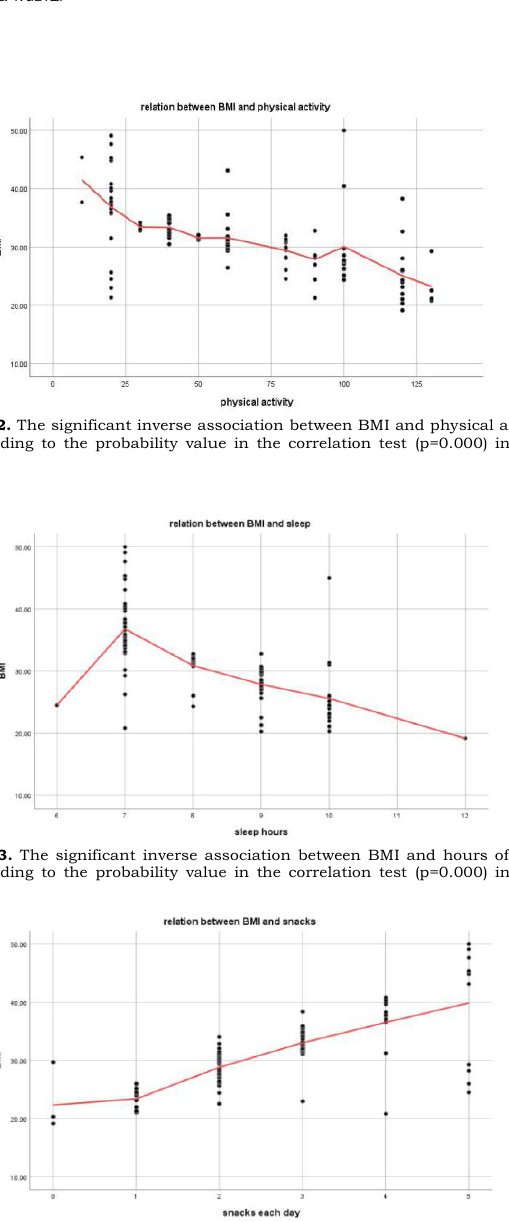
Fig. 4. The significant linear association between number of snacks each day and BMI according to the probability value in the correlation test (p=0.000) in table (2).